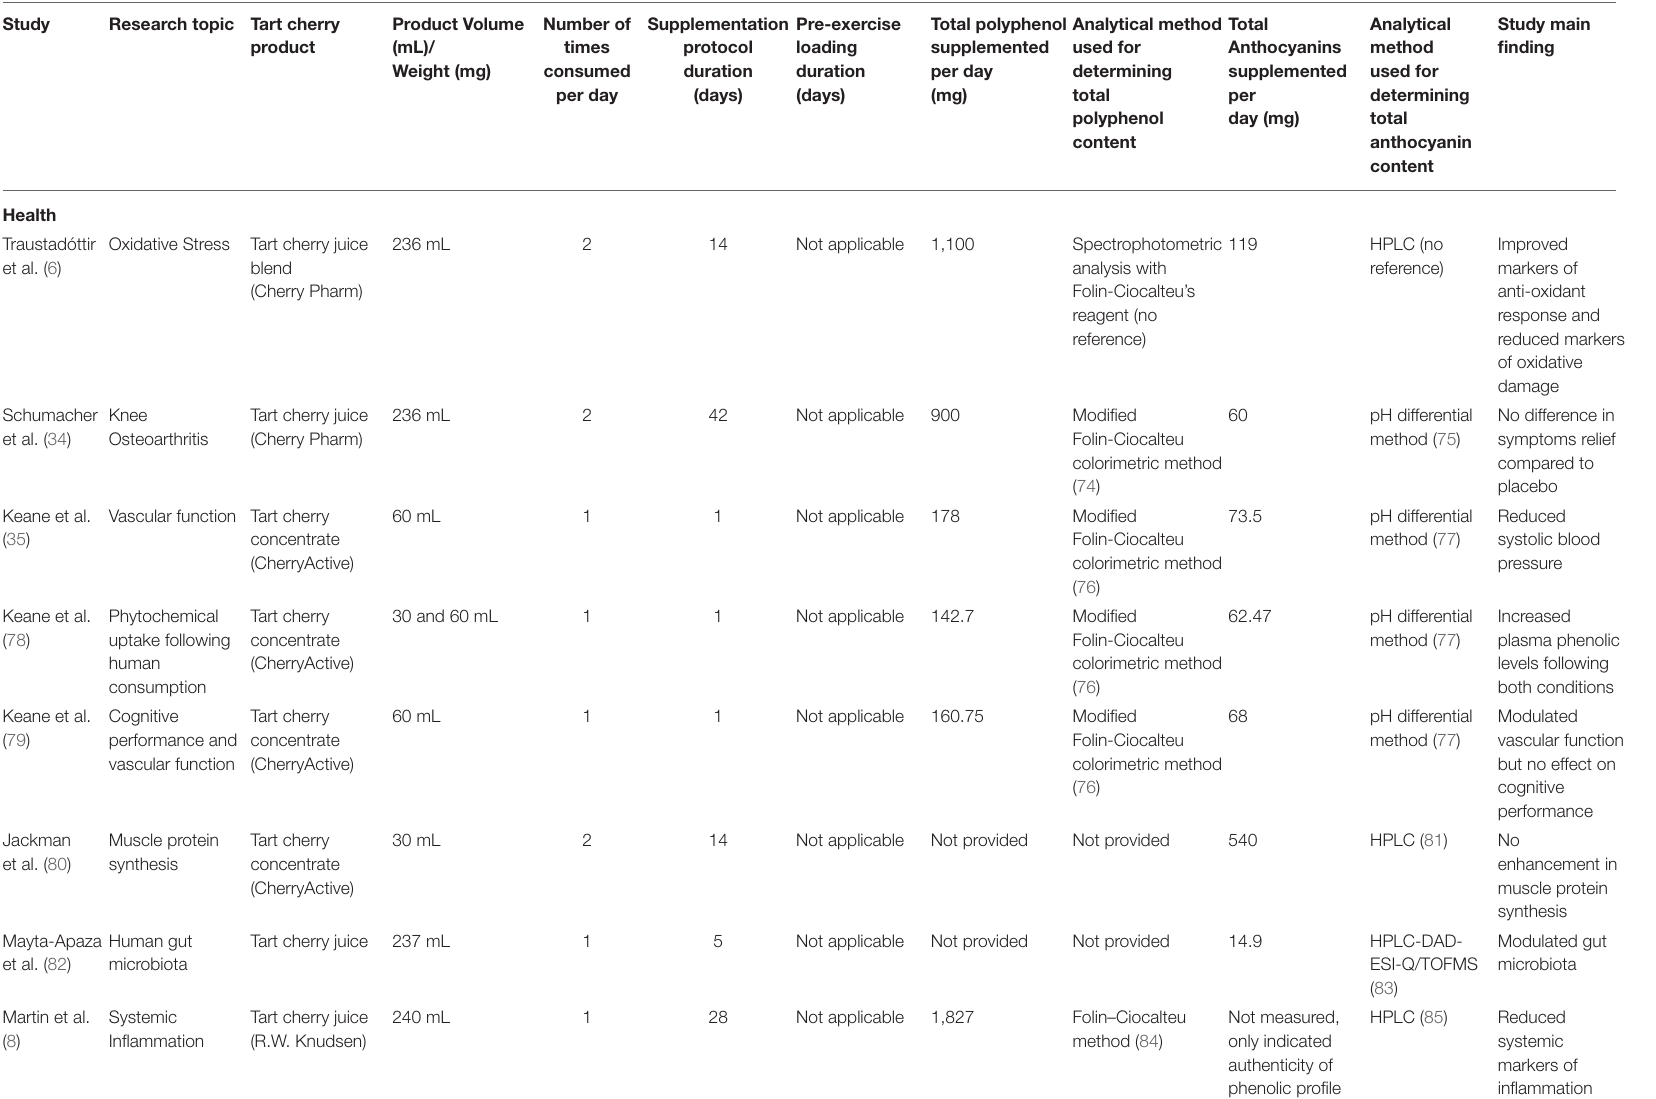
TABLE 2 | Table presenting the extracted data from the tart cherry supplementation studies included in this review that conducted direct analysis on the dietary supplement used in the supplementation